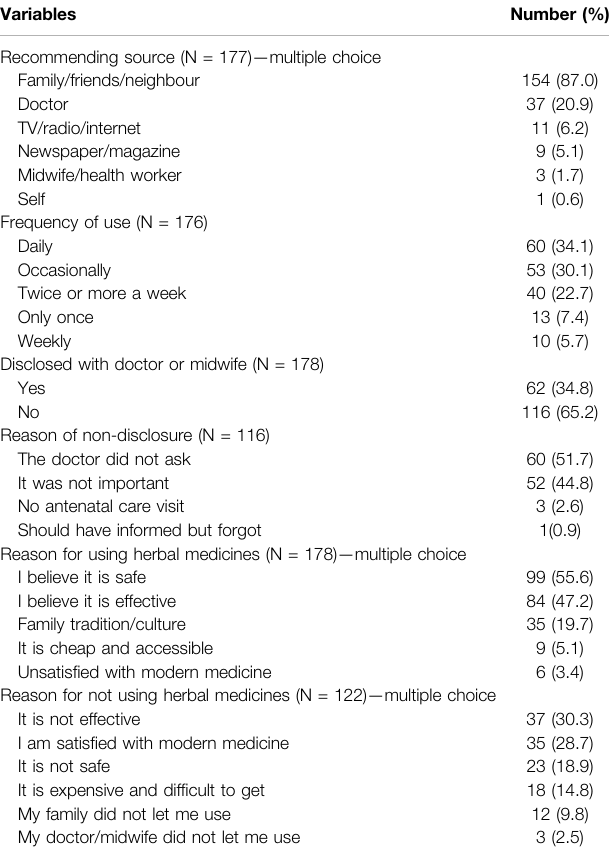
TABLE 7 | Patterns of herbal medicine use during pregnancy.